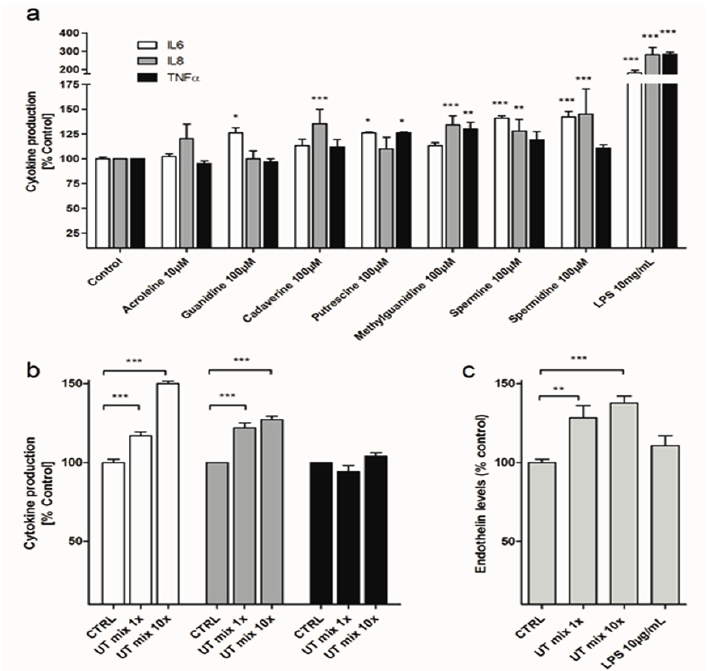
Figure 1. TNF α , IL-6, IL-8 and ET-1 excretions by ciPTEC after exposure to cationic UTs. ( a ) TNF α , IL-6 and IL-8 excretion was measured 24 h after incubation of ciPTEC with 10 µM acrolein, 100 µM of guanidine, cadaverine, putescine, methylguanidine, spermine, spermidine, or 10 µg·mL − 1 LPS; ( b ) TNF α , IL-6 and IL-8 excretion was measured 24 h